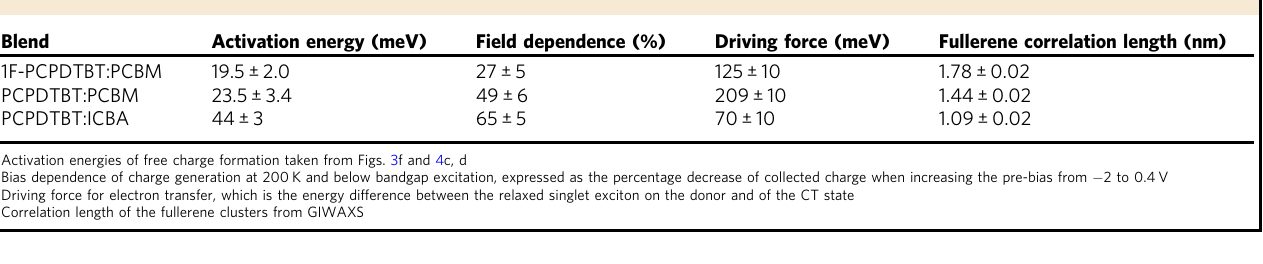
Table 1 Parameters describing the temperature and fi eld dependence of charge generation relative to energetics and morphology from left to right Blend Activation energy (meV) Field dependence (%)